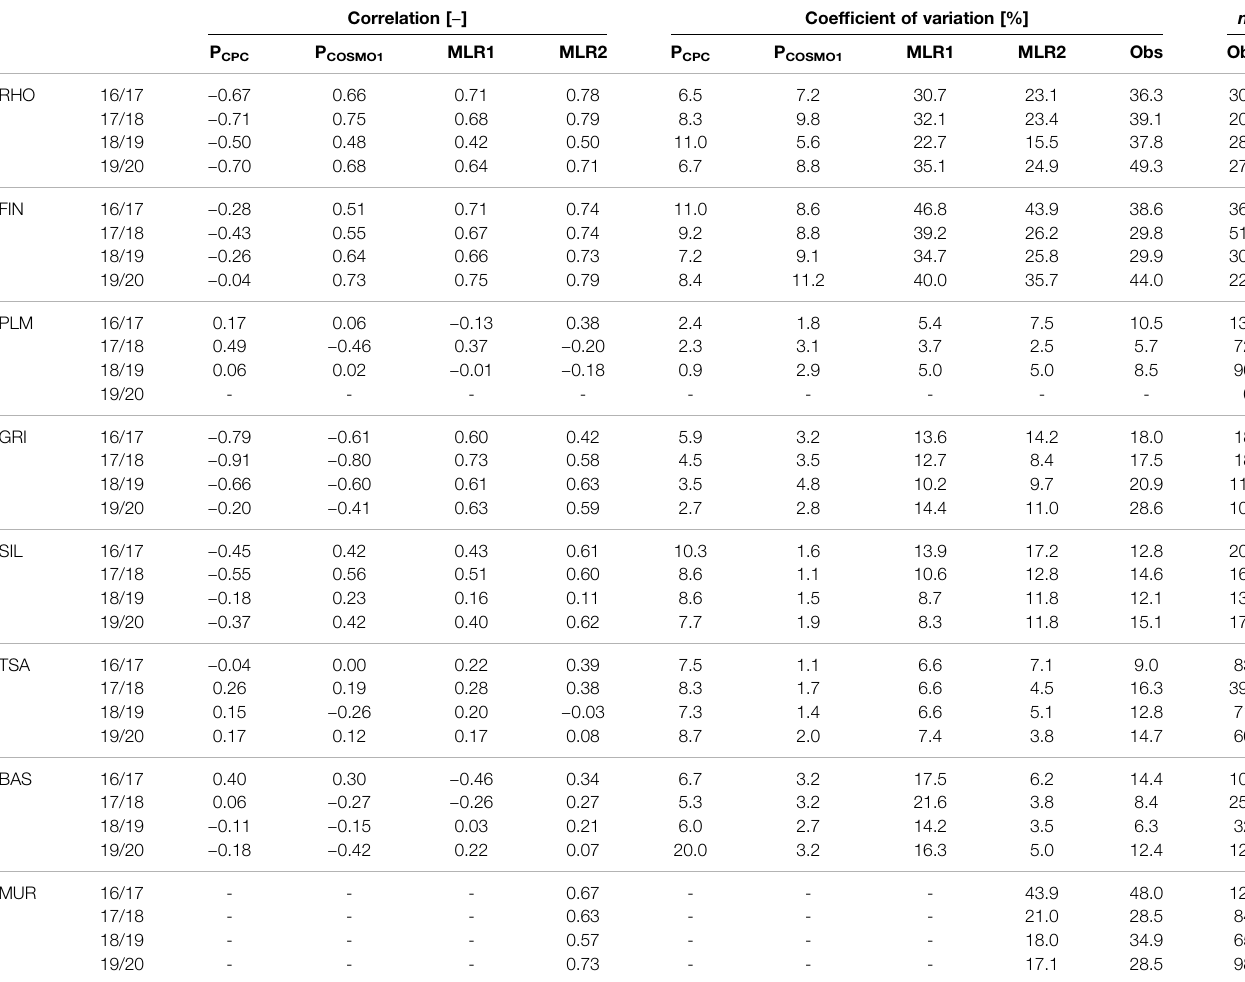
TABLE 4 | CombiPrecip, COSMO-1 precipitation, Step-1 model (MLR1) and Step-2 model (MLR2) correlations with respect to end-of-season in-situ measurements, for all the glaciers and all the winter seasons. Correlation [ − ] Coef fi cient of variation